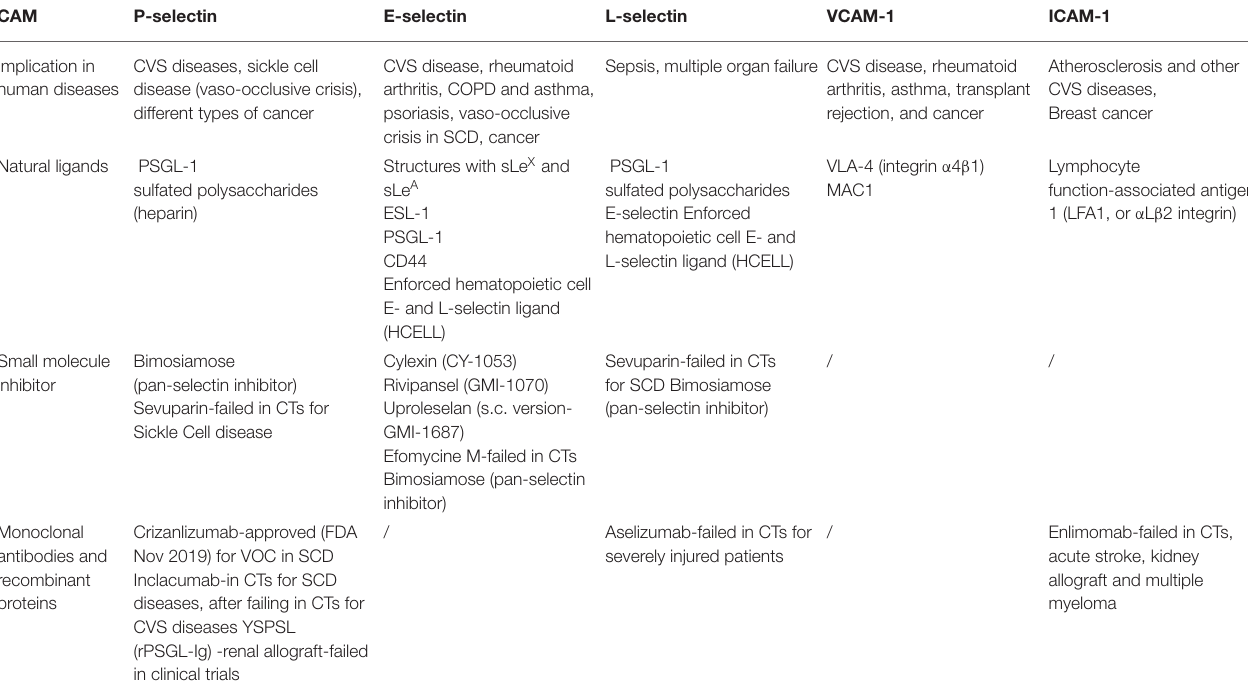
TABLE 1 | Cell adhesion molecules (CAMs) P-, E-, and L-selectin, VCAM-1, ICAM-1 and their implications in human diseases; natural ligands, and low Mw inhibitors/monoclonal antibody drug